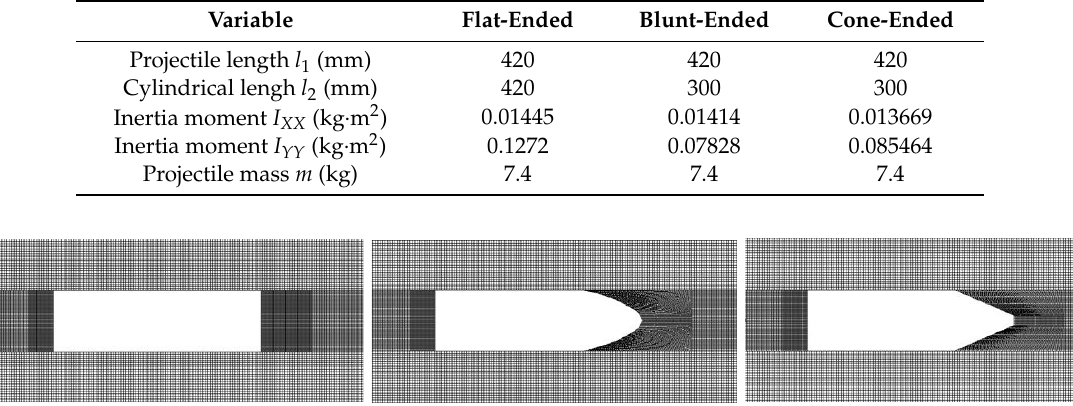
Figure 3. Velocity-time curve of the shell moving in barrel.